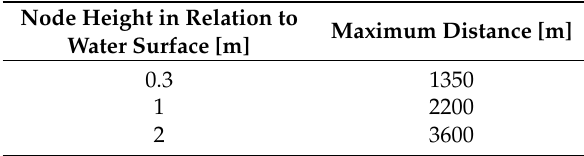
Table 3. Maximum communication distance for different node heights determined by Equation